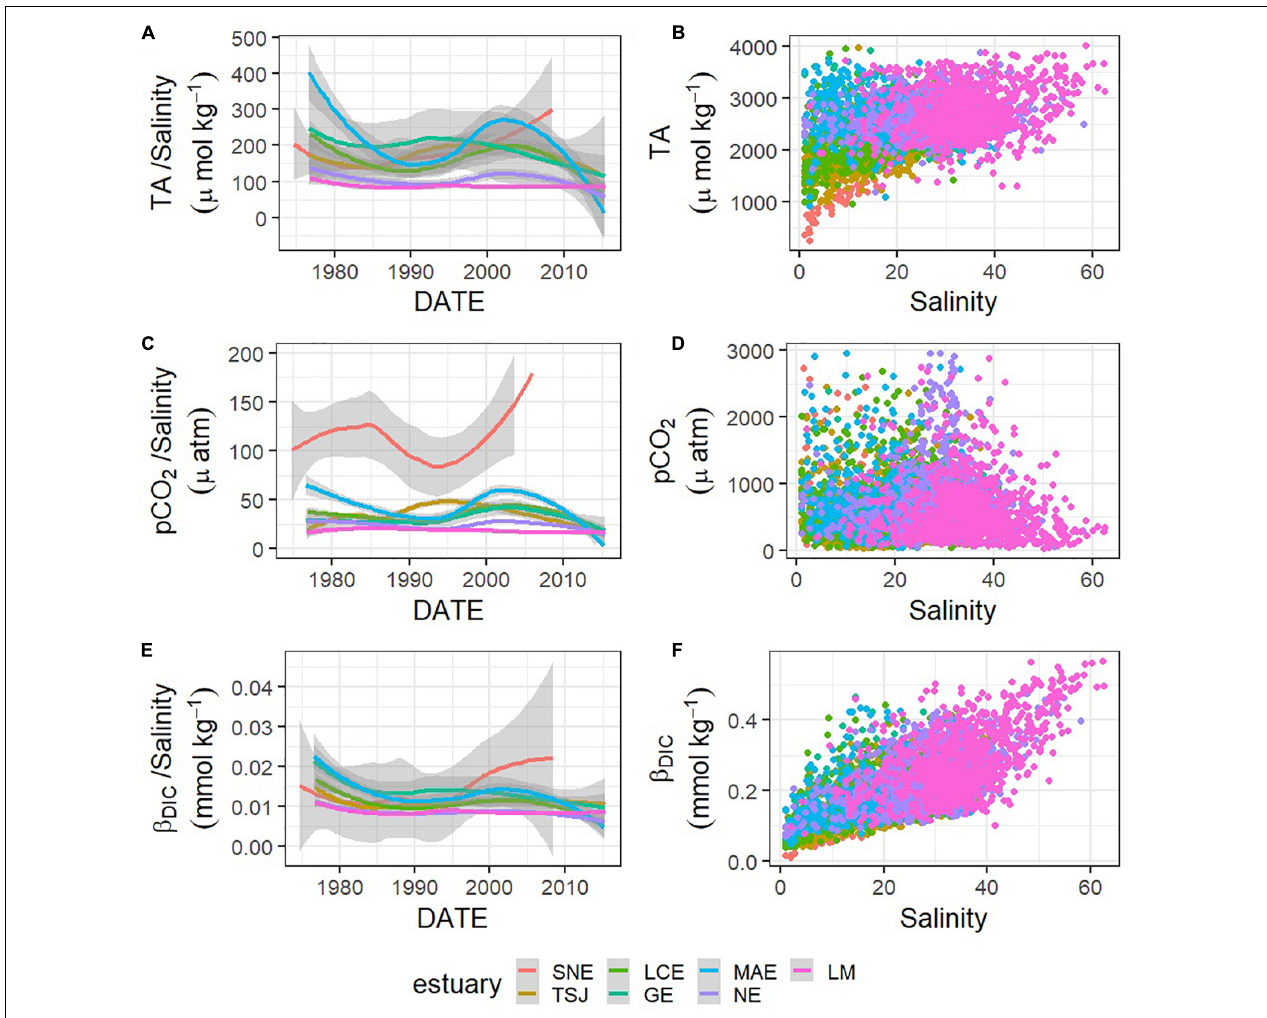
FIGURE 6 | Relationships between carbonate system parameters—TA (A,B) , p CO 2 (C,D) , and β DIC (E,F) —and salinity, and changes in those relationships (change in the ratio between the carbonate system parameter and salinity) represented by loess models over time in each estuary (A,C,E) .